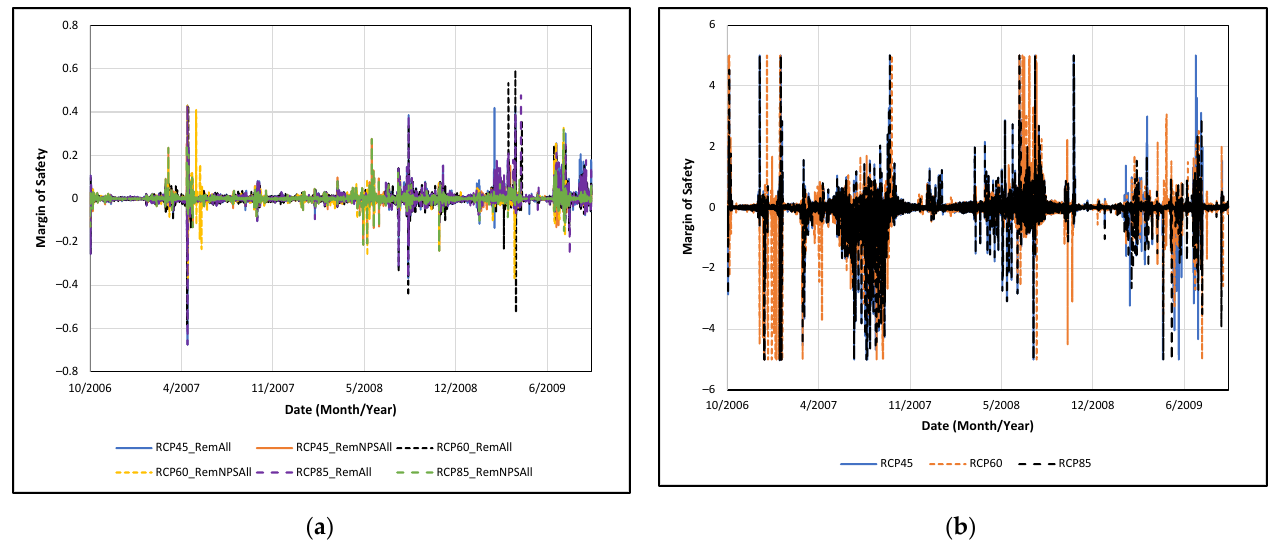
–0.8–0.6–0.4–0.200.20.40.60.8 Figure 2. Suggested Margins of Safety for Theoretical WQT Buyer TN over the Jordan River Simulation (1 October 2006 to 30 September 2009) toward Incorporating Climate Change Characteristics only under Distinct RCP Projections (RCP45 = RCP 4.5; RCP60 = RCP 6.0; RCP85 = RCP 8.5) for ( a ) Delivery and ( b ) Downstream Trade Components. Figure 3. Suggested Margins of Safety for Theoretical WQT Buyer TN over the Jordan River Simulation (1 October 2006 to 30 September 2009) for the Equivalency Trade Ratio Component toward Climate Change Characteristics only under Distinct RCP Projections (RCP45 = RCP 4.5; RCP60 = RCP 6.0; RCP85 = RCP 8.5) and under Removal Case F (Removal upon All) for ( a ) Buyer TN to Seller TP and ( b ) Buyer TN to Seller BOD. Figure 4. Suggested Margins of Safety for Theoretical WQT Buyer TN over the Jordan River Simulation (1 October 2006 to 30 September 2009) with Population Characteristics only under Distinct RCP Projections (RCP45 = RCP 4.5; RCP60 = RCP 6.0; RCP85 = RCP 8.5) for Inflow Increase by 1.15 for ( a ) the Delivery and ( b ) Downstream Trade Ratio Components.